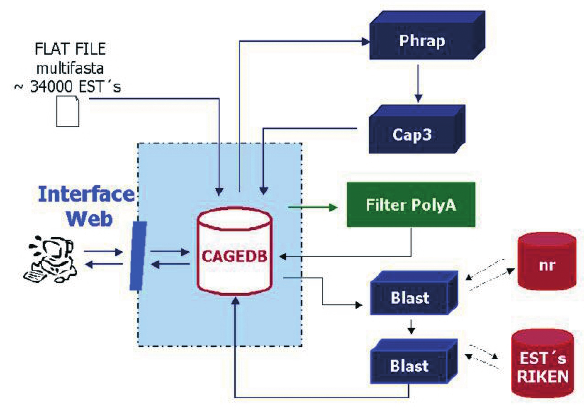
Figure 1 - Pipeline for Gene